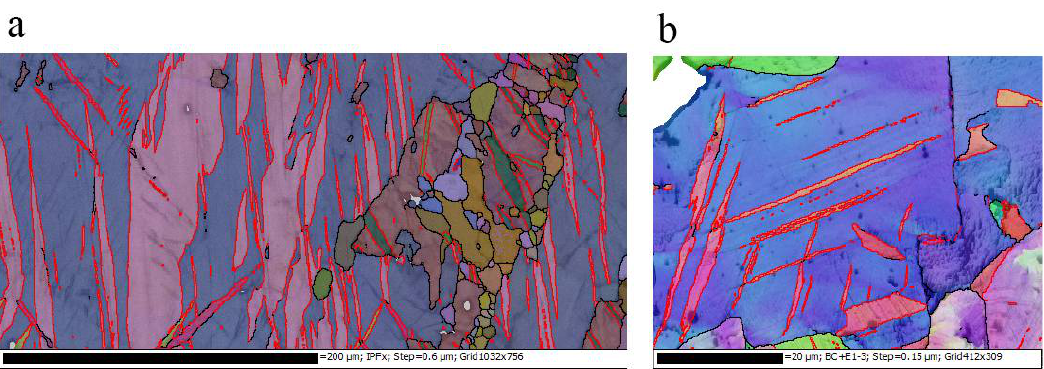
Figure 31. EBSD maps of lenticular deformation twins, ( a ) formed in recrystallized pure (hcp) magnesium; and ( b ) in a (fcc) TWIP steel (kindly given by K. Zhu, ArcelorMittal). The twin boundaries are marked in red; they are identified by the misorientations (87° ± 5°, [001] hex ) and (60° ± 5°, <111> fcc ) in ( a , b ), respectively.